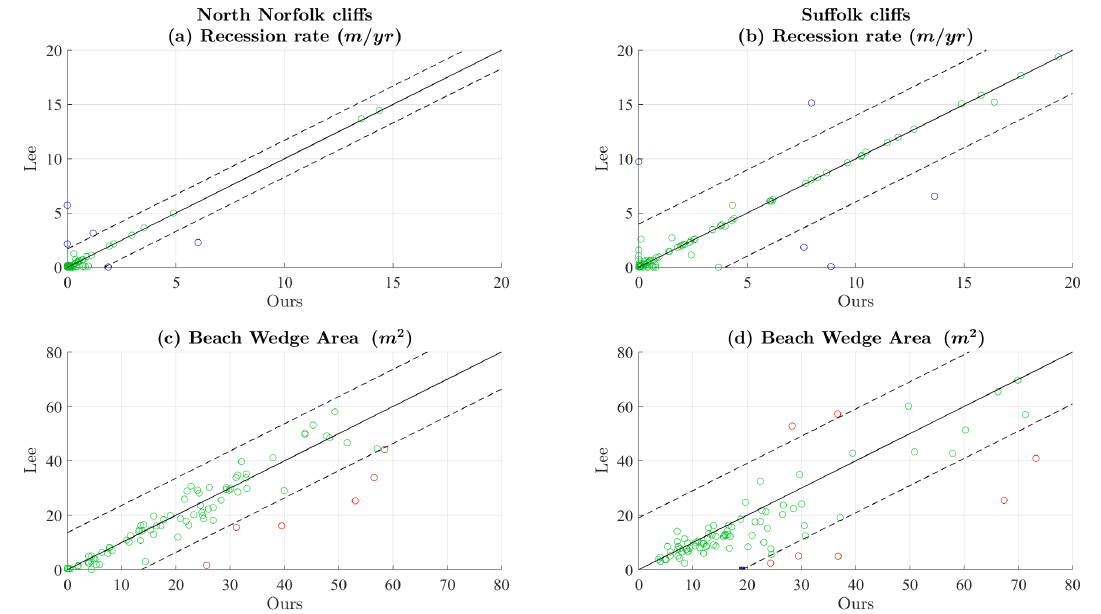
Figure A4. Scatter plot using [3] and our calculated cliff top recession rate and BWA for North Norfolk ( a , c ) and Suffolk ( b , d ) cliffs. The blue and red marked points are outliers from recession rate and BWA, respectively. Here, we used the updated MHWS (see Table